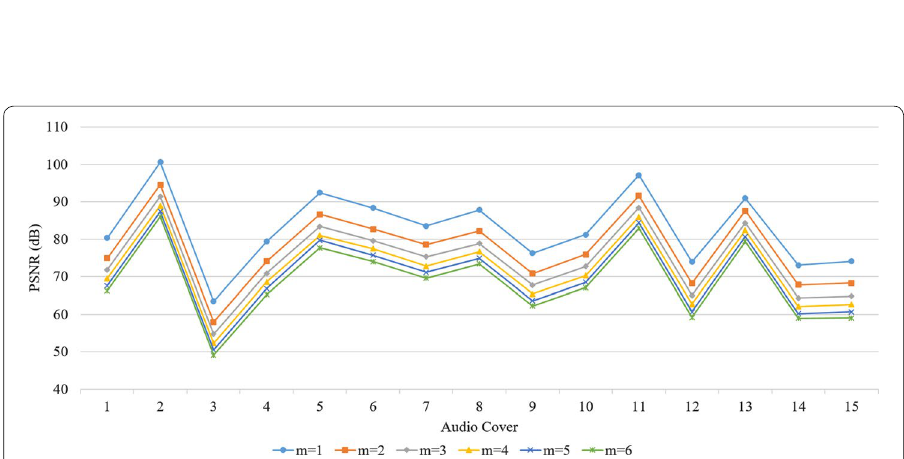
Fig. 6 The average of stego quality, where m ∈ { 1,2,3,4,5,6 } , e = 3 and h =